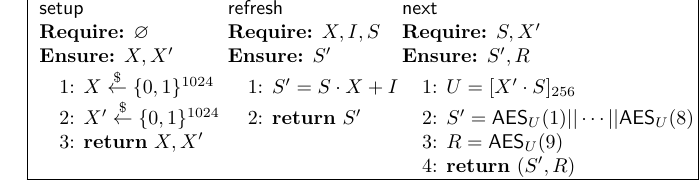
Figure 19: ROB : A Secure